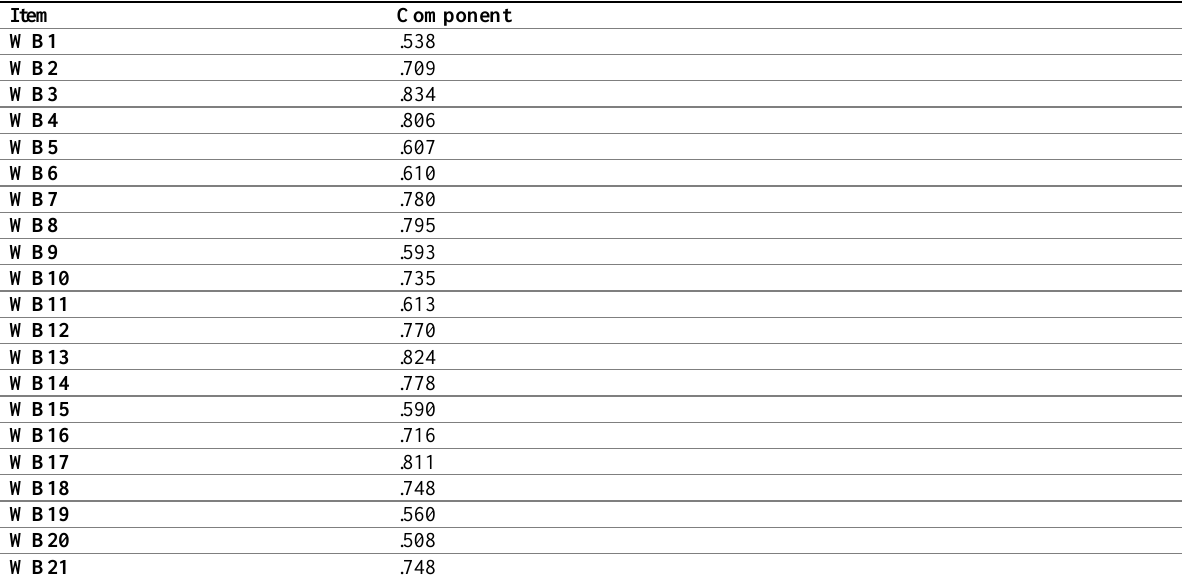
Table 8: Exploratory Factor Loadings of the Workplace Bullying (n=45)